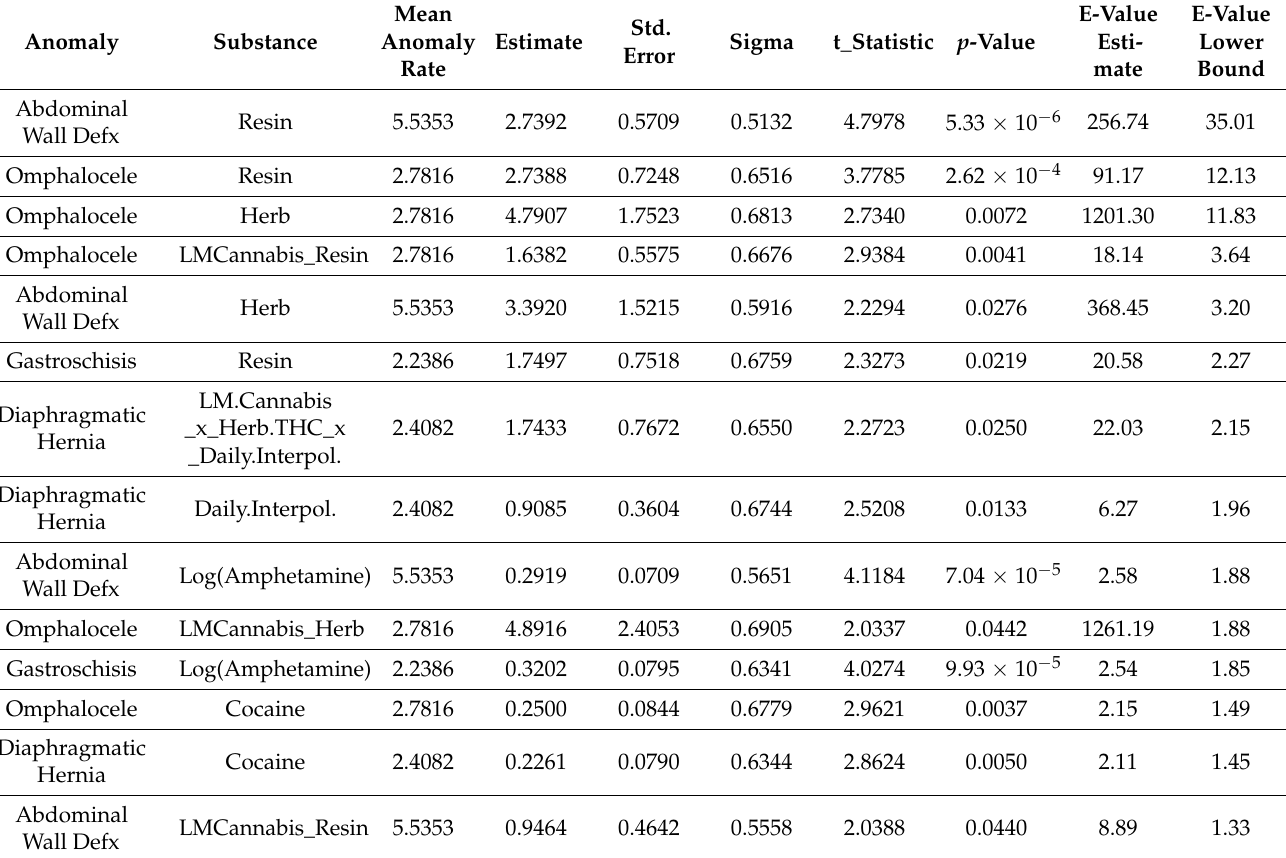
Table 1. Significant Positive Slopes of Anomaly by Substance Regression